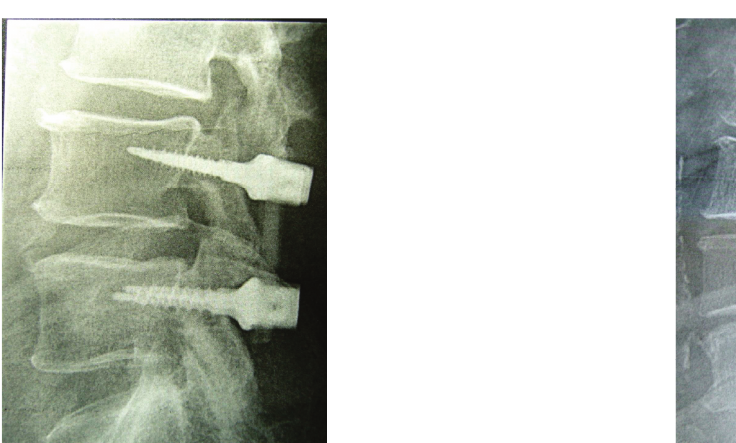
Figure 2: Lateral radiograph of the lumbar spine of a 74-yo patient with a canal stenosis shows spinal stability plus segmental and adjacent discs preservation.